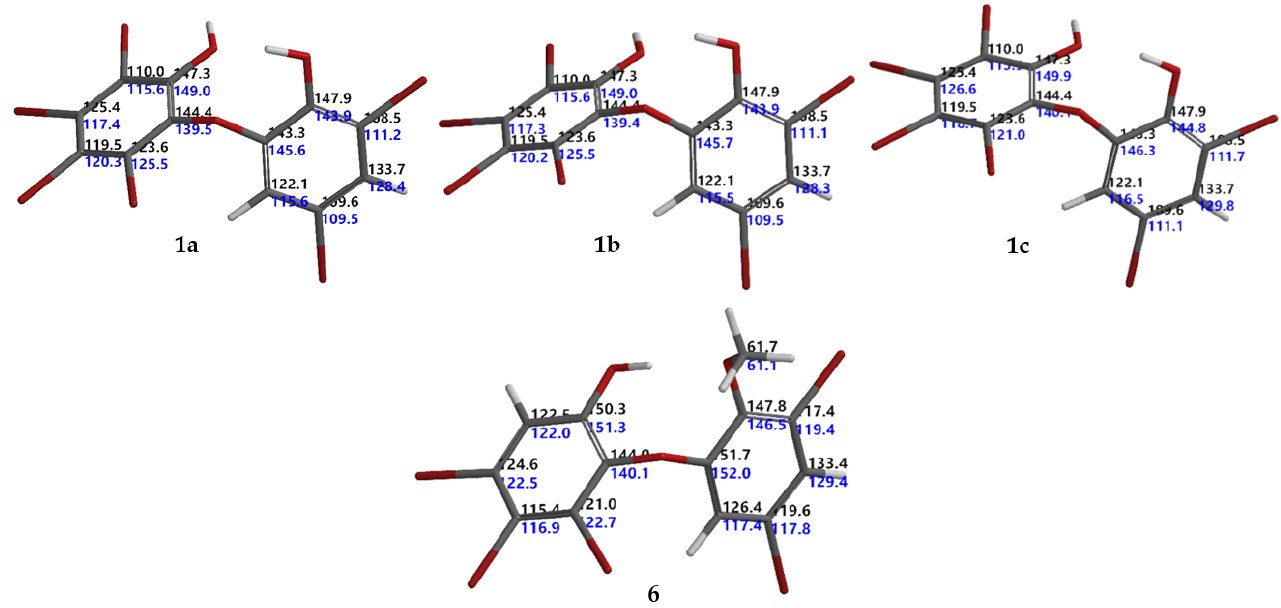
Figure 2. Calculated and experimental 13 C NMR chemical shifts for 1a , 1b , 1c , and 6 corresponding to their RMSEs 4.3, 4.4, 3.5, and 3.2 ppm, respectively. Black indicates calculated, while blue denotes experimental 13 C NMR chemical shifts.